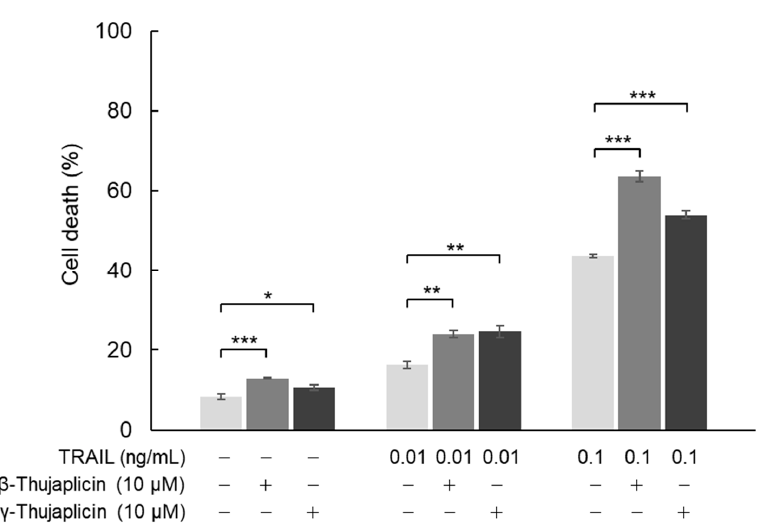
Figure 4. Enhancement of the TRAIL cell death induction effect on NCI-H460 cells through a combi- nation treatment with β -thujaplicin. NCI-H460 cells were cotreated with the indicated concentrations of TRAIL and β - or γ -thujaplicin for 24 h. Cell death (%) was determined by a trypan blue exclusion assay. Data are the averages of three independent experiments and error bars show standard devia- tions. Asterisks (*, **, and ***) indicate p value smaller than 0.05 ( p < 0.05), 0.01 ( p < 0.01), and 0.001 ( p < 0.001),